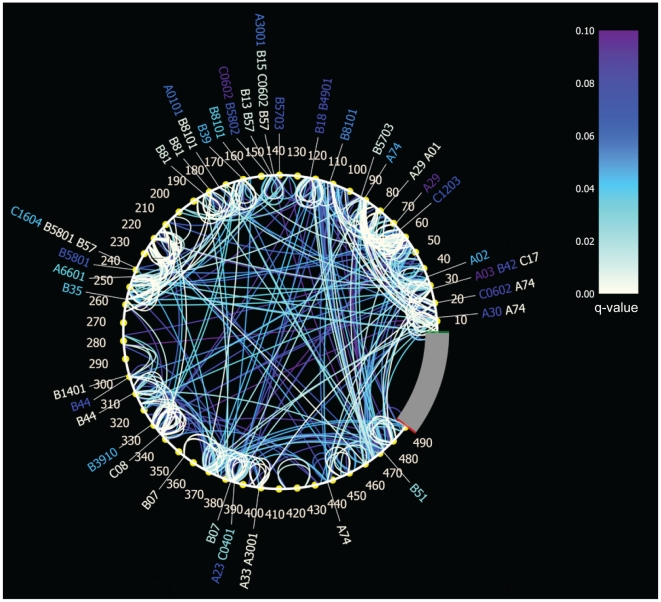
Amino Acid associations in HIV-1 subtype C Gag.Associations are depicted with a circular map: AA interactions among residues are represented with arcs, which are color-coded with a white to purple gradient – white corresponding to the strongest associations (i.e., lower q-values). HLA-restricted sites are identified by the HLA allele designations around the circle.